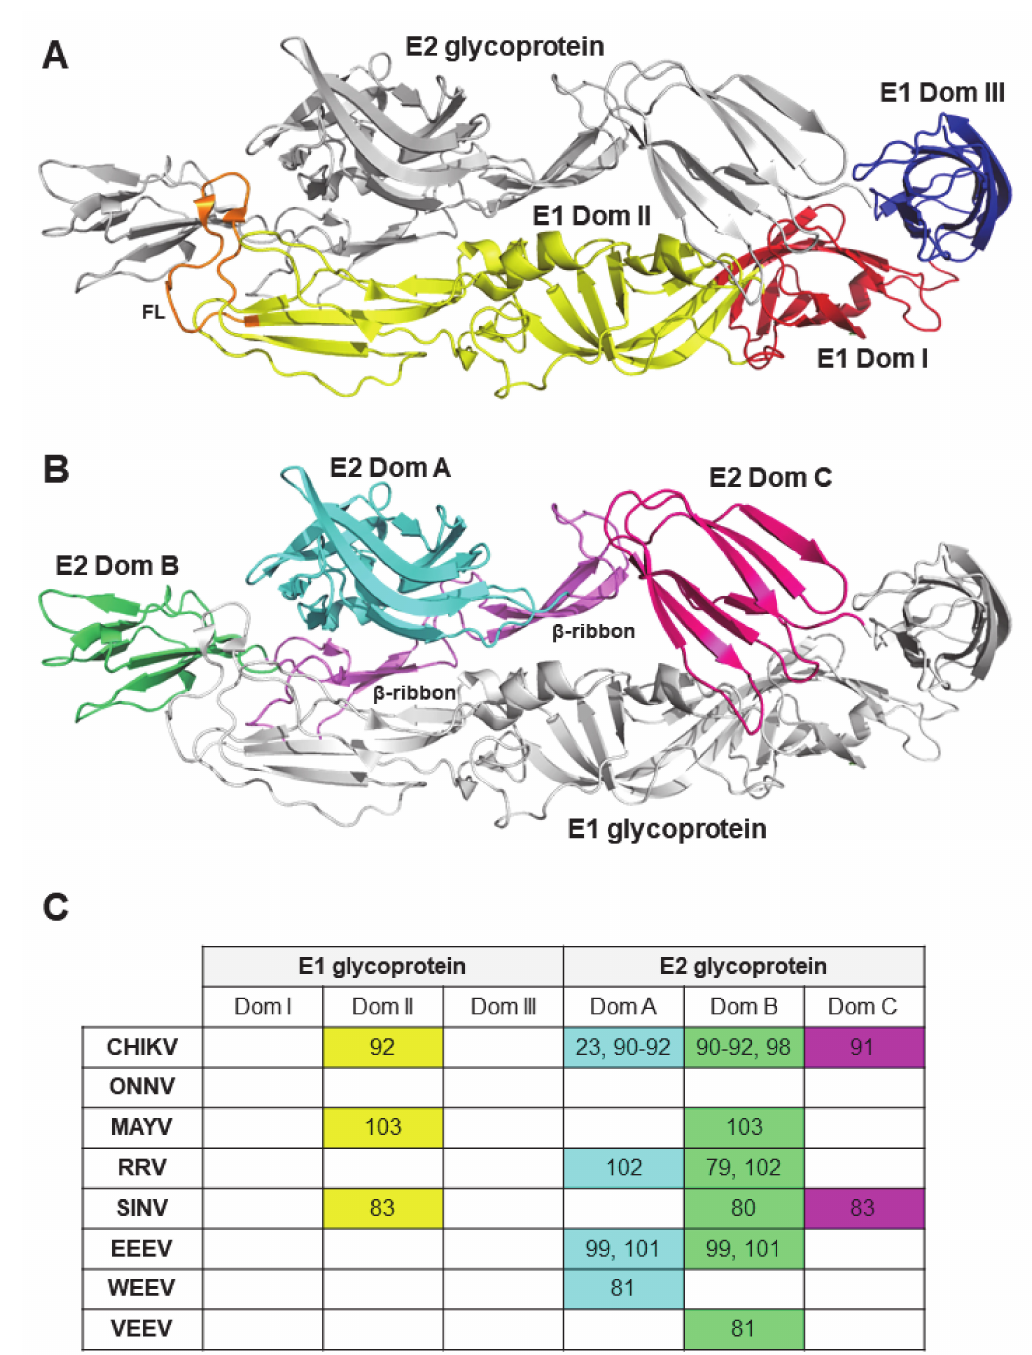
Figure 1. Structure of the alphavirus E1-E2 heterodimer. Ribbon diagram (PDB: 3N41) highlighting ( A ) E1 glycoprotein (domain I: red, domain II: yellow, domain III: blue, fusion loop FL: orange, E2: grey) and ( B ) E2 glycoprotein (domain A: cyan, domain B: green, domain C: pink, beta-ribbons: purple, E1: grey). ( C ) Table summarizing reported antibody binding regions in the E1 and E2 glycoproteins of arthrogenic and neurotropic alphaviruses. Numbers in the table refer to in-text citations describing such binding sites (See Reference list). Background color matches protein doimains depicted in ( A ) and ( B ). To assess for the degree of conservation among common antigenic regions across alphaviruses a sequence aligment analysis was conducted (See Supplementary Figure